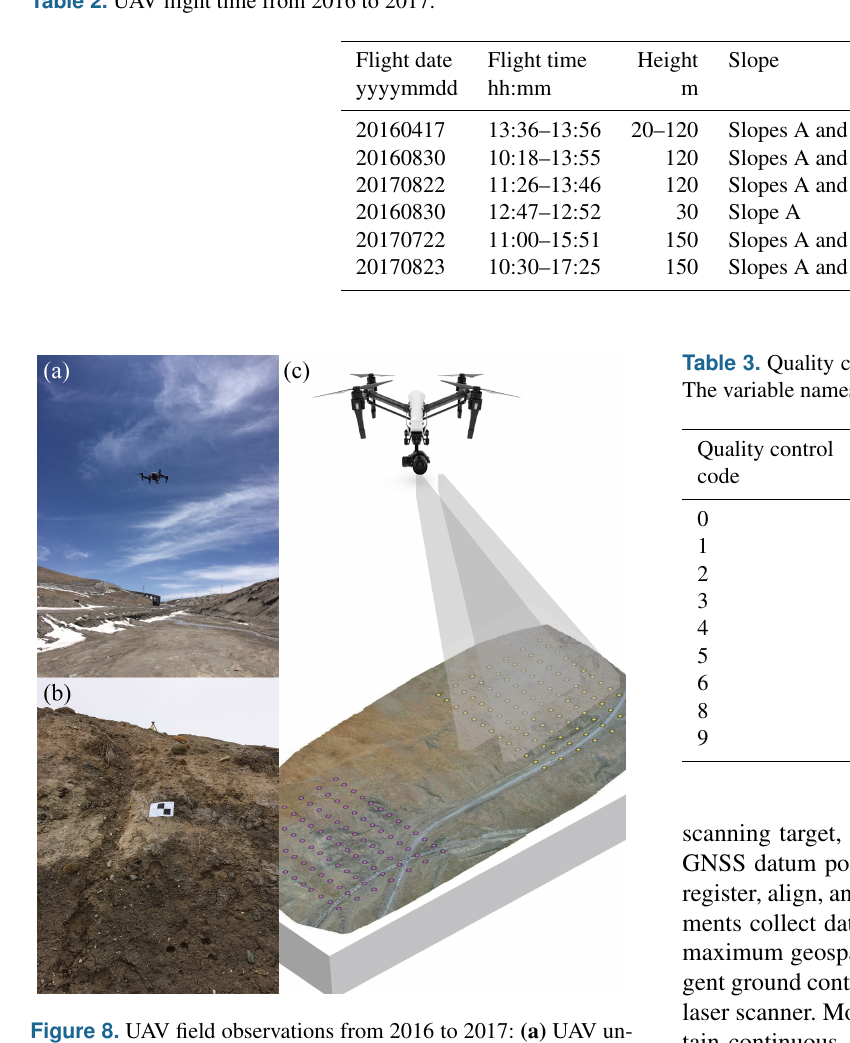
Figure 8. UAV field observations from 2016 to 2017: (a) UAV un- der observation, (b) GNSS and rectangular white and black card- board, and (c) UAV flight path over the two permafrost slopes.